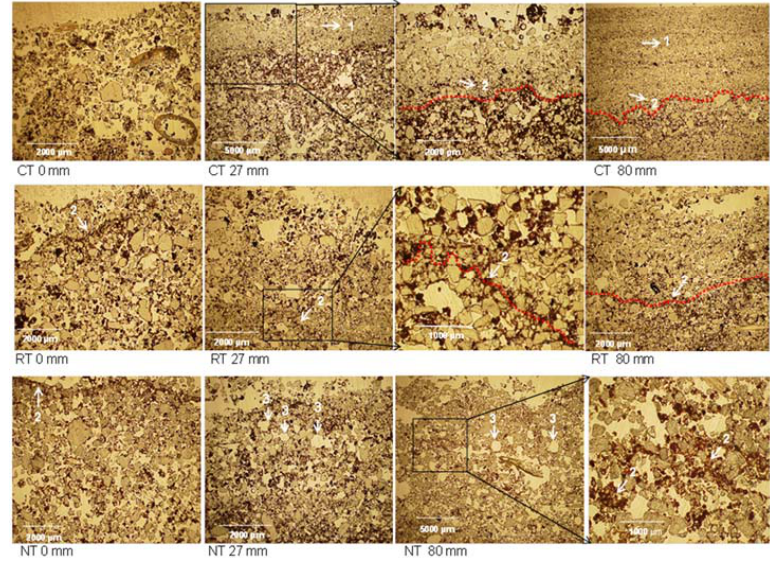
Figure 6. Images of thin sections vertically oriented for the different tillage systems and rainfall amount applied. 1: crust formed, quartz grains arranged after simulated rainfall; 2: lamination of accumulated fine material; 3: rounded pores (vesicles); CT: Conventional Tillage; RT: Reduced Tillage; NT: No-Tillage; 0, 27, 54 and 80 mm: simulated rainfall